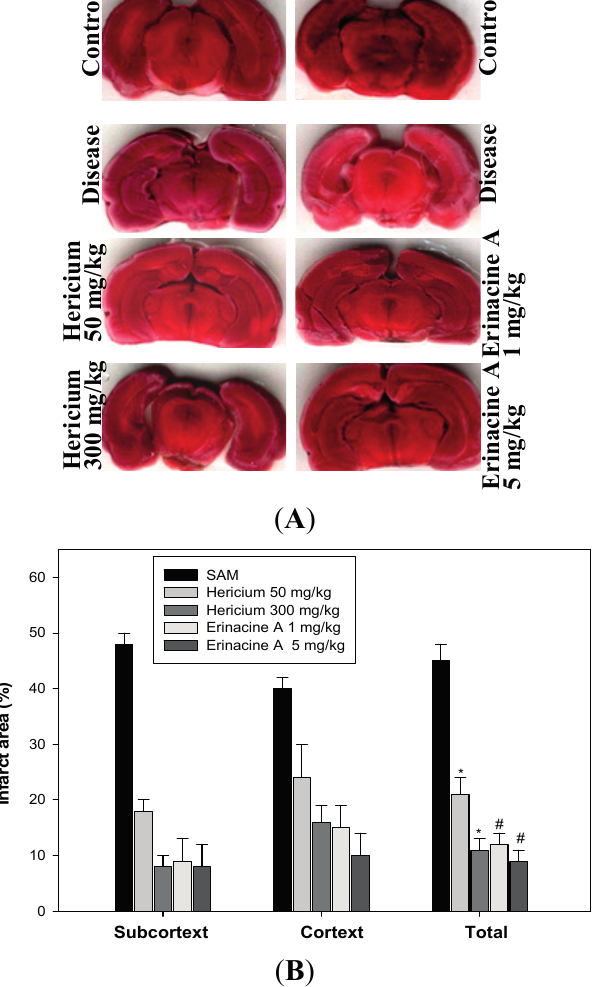
group for both cortical and subcortical infarctions (see Figure 3B, * p < 0.05). There was also an increase in the number of positive NeuN cells, when the SAM rats treated with 1, 5 and 10 mg/kg erinacine A were compared with the untreated SAM rats (Figure 3B, # p < 0.05). Figure 2. Effects of Hericium erinaceus mycelium on infarcted volume in ischemic rats. The stroke animal model (SAM rat 1.5 h and reperfusion 24 h) was applied to rats as described in Experimental Section 4.2. H. erinaceus and erinacine A were administered intraperitoneally 90 min after the initial ischemia. The control group and SAM group animals received an equal volume of solvent. ( A ) Representative ischemic lesions at 2 mm thick coronal section from H. erinaceus at the dose of 50 and 300 mg/kg and erinacine A at the dose of 1 and 5 mg/kg (injection at 90 min in pre-stroke rats) as well as DMSO-treated rats at 1 day 2,3,5-triphenyl tetrazolium chloride (TTC) staining before ischemia; ( B ) Quantitative analysis of total infarcted volume to determine the therapeutic dose in groups of six rats treated with DMSO (control) or H. erinaceus and erinacine A at 24 h in pre-stroke rats. Cortex, subcortex, and total infarcted volumes were determined in the transient stroke rats (shown as percentage of the hemisphere). Data are expressed as mean ± SD of independent experiments. n = 6. * p < 0.05, SAM group versus SAM + H. erinaceus group. # p < 0.05, SAM group versus SAM + erinacine A group.